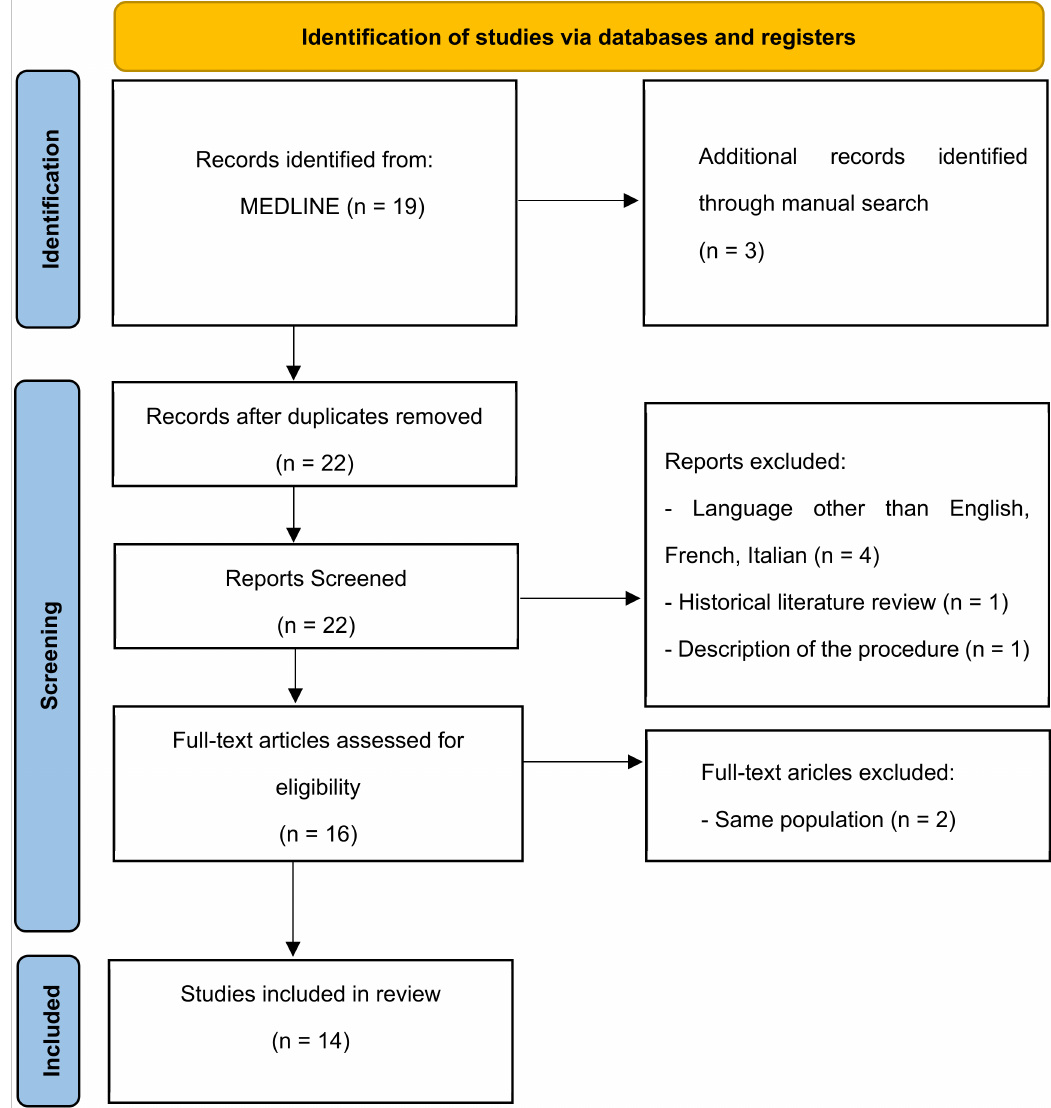
Figure 1. Flow chart of the